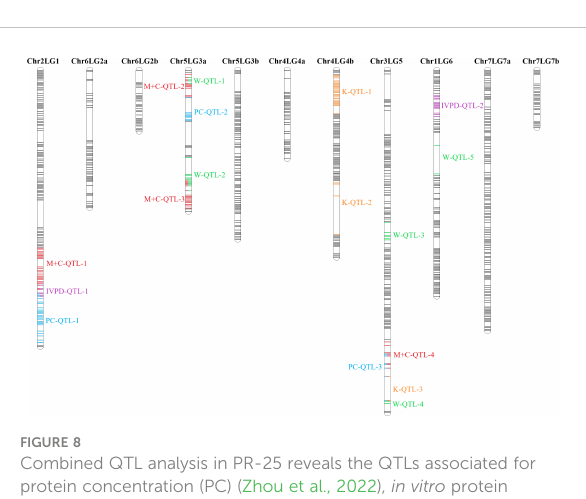
FIGURE 8 Combined QTL analysis in PR-25 reveals the QTLs associated for protein concentration (PC) (Zhou et al., 2022), in vitro protein digestibility (IVPD), lysine concentration (K), tryptophan concentration (W) and methionine + cysteine concentration (M+C). Combined analysis was based on averaged phenotypic data from